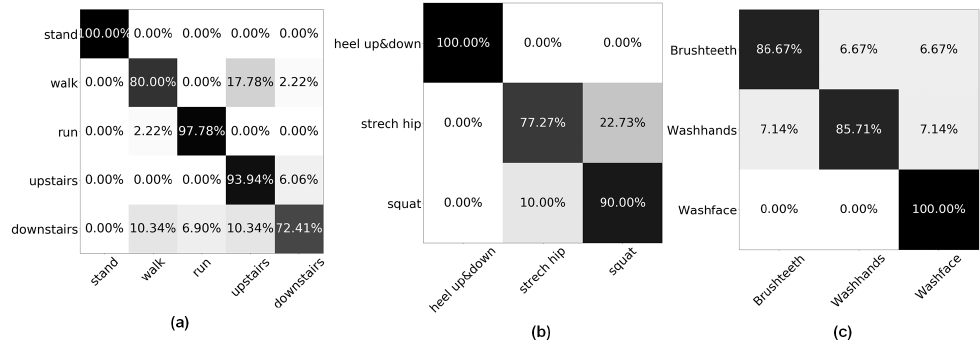
Figure 11. The confusion matrix of using a virtual classifier to recognize the real activity; ( a ) the results of Case 1; used positions are chest, right lower leg, and left lower leg; ( b ) the results of Case 2; the sensor positions are left lower leg-left and left upper leg-left; and ( c ) the results of Case 3; two sensor boards are used, i.e., the location number of [0, 1, 2, 3, 4] and [5, 6, 7, 8,